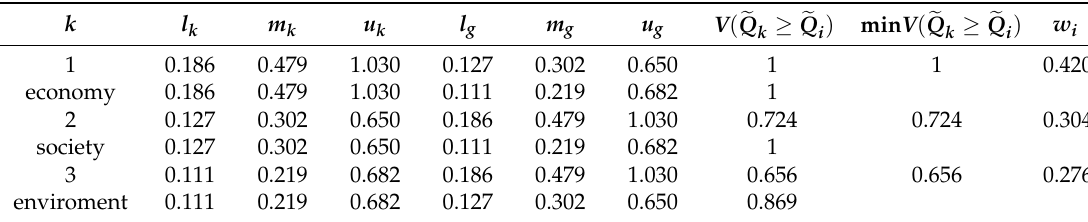
Table 5. Priorities for main criteria with calculations.